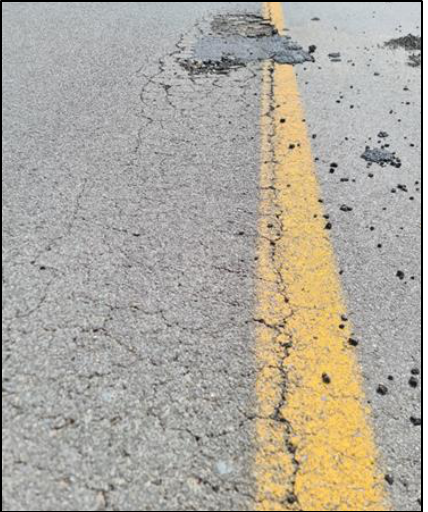
Figure 2. The second kind of micro-cracks is visible against the yellow line contrast.